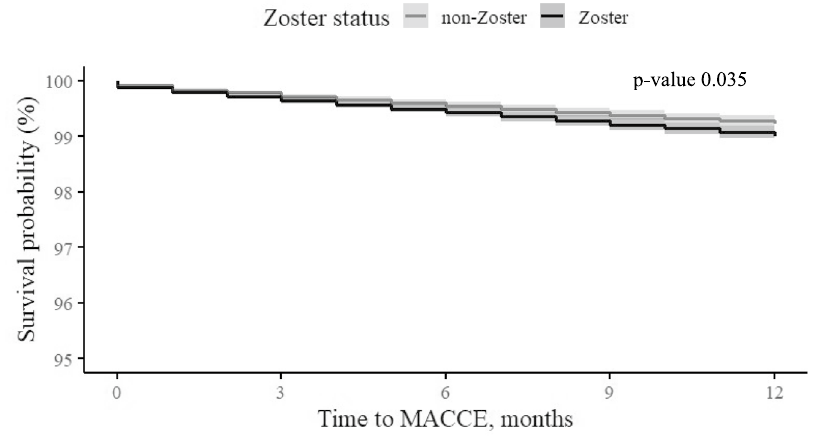
Figure 1. Adjusted* MACCE-free survival time at the first year after exposure to zoster, by zoster status (95% CI). * Adjusted to gender, age, socioeconomic status, diabetes mellitus, hypertension, socioeconomic status, dyslipidemia and prior AMI.